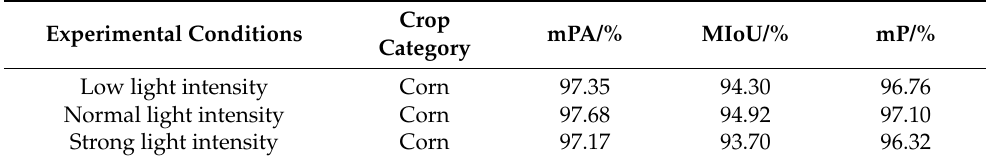
Table 3. Semantic segmentation accuracy test results.